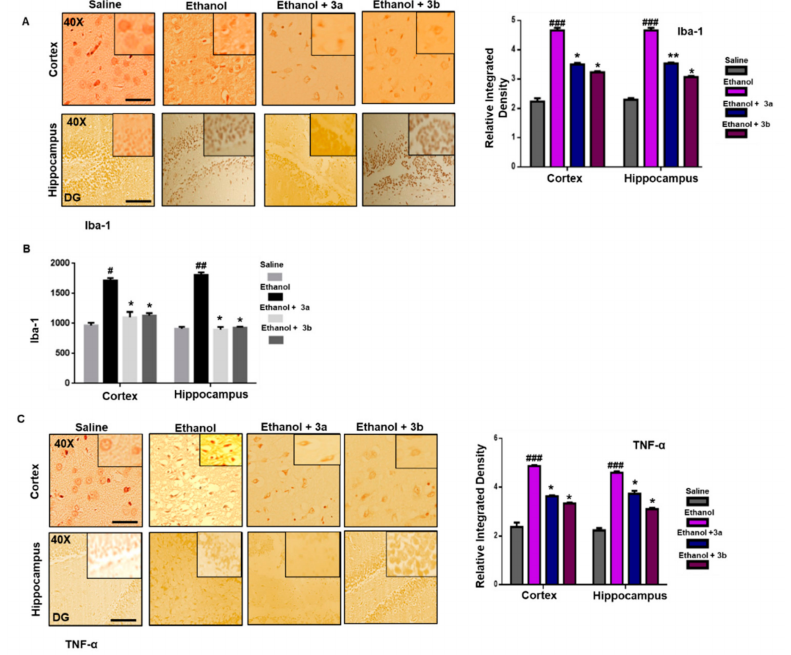
Figure 5. ( A ) Immunohistochemistry results for Iba-1 in the cortex and Dg region of the hippocampus. Bar 20 µ m, magnification 40 × ( n = 6 / group). Histograms show a comparatively higher expression of Iba-1 in the ethanol group. ** and * show p < 0.01 and p < 0.05, respectively, and indicate significant di ff erence relative to ethanol, while ### p < 0.001 shows significant di ff erence relative to saline group. Data are presented as mean ± SEM. Data are analyzed by one-way analysis of variance (ANOVA) followed by post hoc Bonferroni multiple comparison test using GraphPad Prism 6 software. ( B ) The protein expression of Iba-1 quantified using enzyme-linked immunosorbent assays (ELISA). The data were expressed as the mean ± SEM. * p < 0.05 relative to ethanol, while # p < 0.05 and ## p < 0.01 relative to saline ( n = 6 / group). ( C ) Immunohistochemistry results of TNF- α in the cortex and Dg region of the hippocampus. Bar 20 µ m, magnification 40 × ( n = 6 / group). Histograms show a comparatively higher expression of TNF- α in the ethanol group. * shows p < 0.05 and indicates significant di ff erence relative to ethanol, while ### p < 0.001 shows significant di ff erence relative to the saline group. Data are presented as mean ± SEM. Data are analyzed by one-way ANOVA followed by post hoc Bonferroni multiple comparison test using GraphPad Prism 6